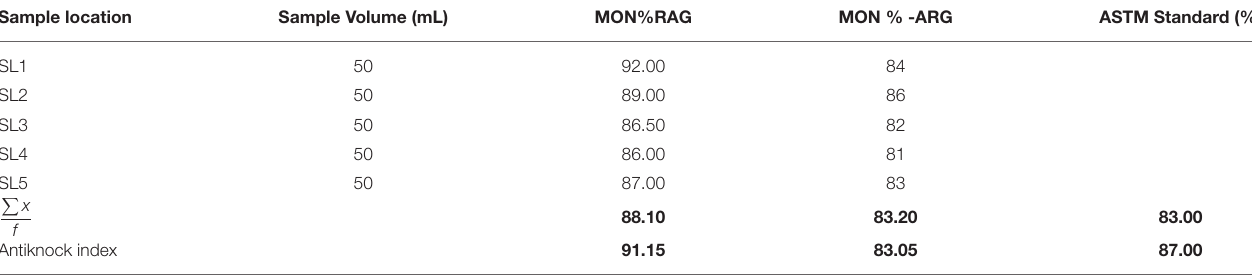
TABLE 2 | Motor octane number for regular automotive gasoline (RAG) and artisanal refine gasoline (ARG). Sample